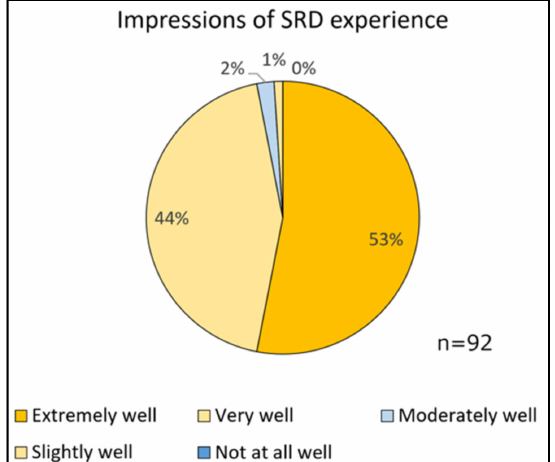
Figure 10. Impressions of the SRD experience.